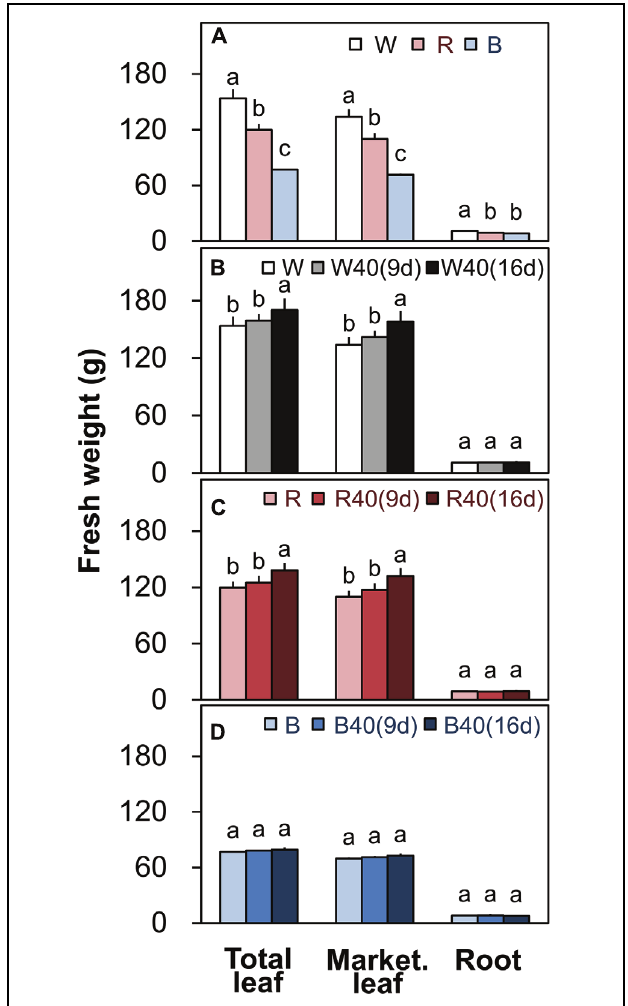
FIGURE 4 | Total leaf fresh weights, marketable leaf fresh weights, and root fresh weights of plants grown under (A) white (W), red (R), and blue (B) LEDs without supplemental upward lighting, or under the same downward lighting from above with supplemental upward lighting from (B) white, (C) red, or (D) blue LEDs. Data represent means ± SD ( n = 3 to 5). Supplemental upward lighting was provided for 9 days (“9d”) or 16 days (“16d”) at 40 µ mol m − 2 s − 1 PPFD. Bars labeled with different letters differ significantly (Tukey’s HSD test, P <